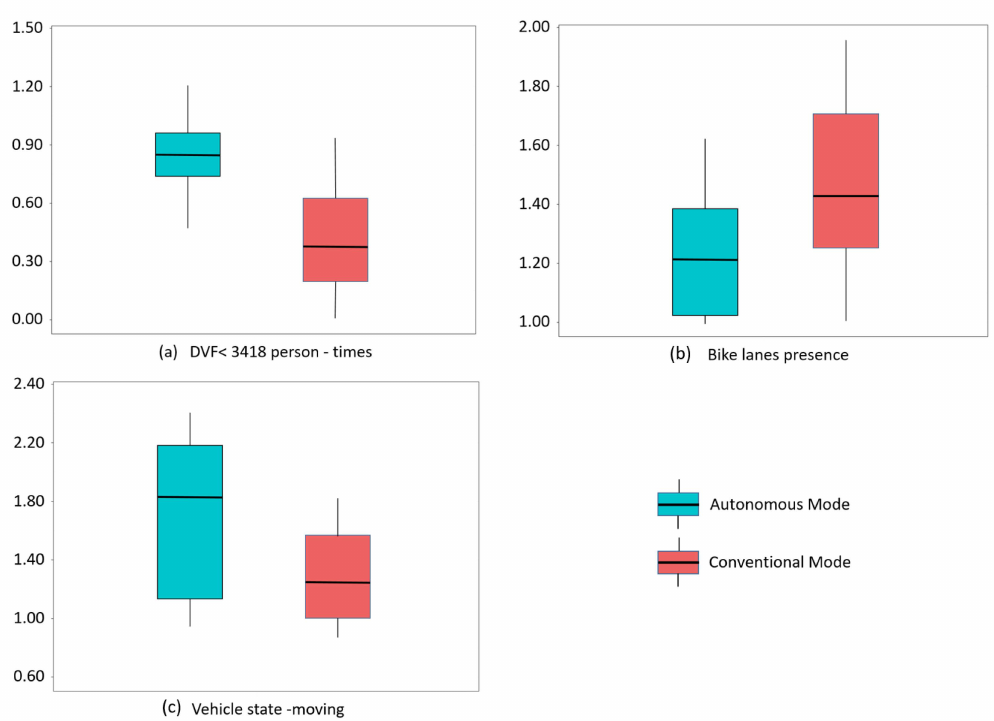
Figure 5. Comparison of the same influencing factors for crash severity in autonomous and conven- tional driving